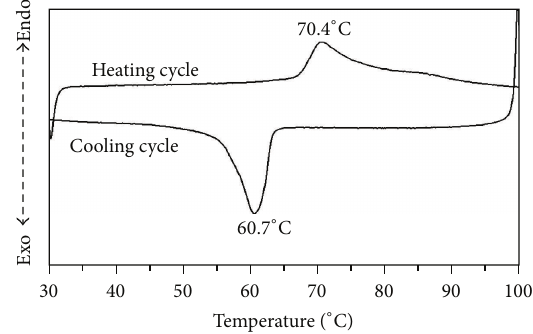
Figure 10: DSC curves of VO 2 (M) powders prepared by calcination of the 300 W microwave heated samples at 500 ∘